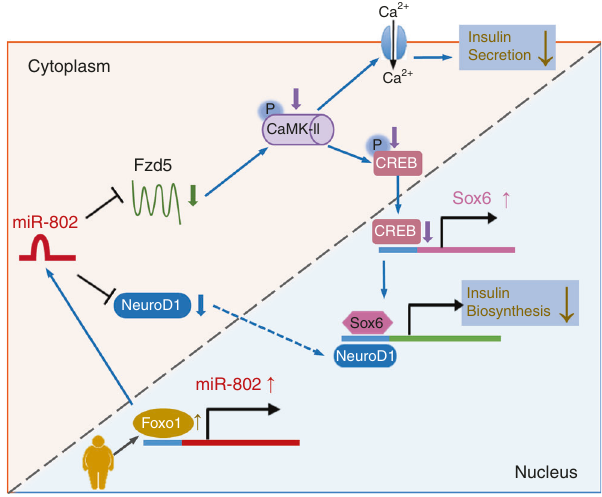
Fig. 9 A working model that illustrates the mechanism by which silencing of miR-802 impairs β cell function-targeted NeuroD1 and Fzd5 . Obesity predisposes to type 2 diabetes, but the mechanisms of obesity-associated beta-cell dysfunction are incompletely understood. Here the authors report that obesity increases the levels of miR-802, which impairs insulin transcription and secretion by targeting NeuroD1 and